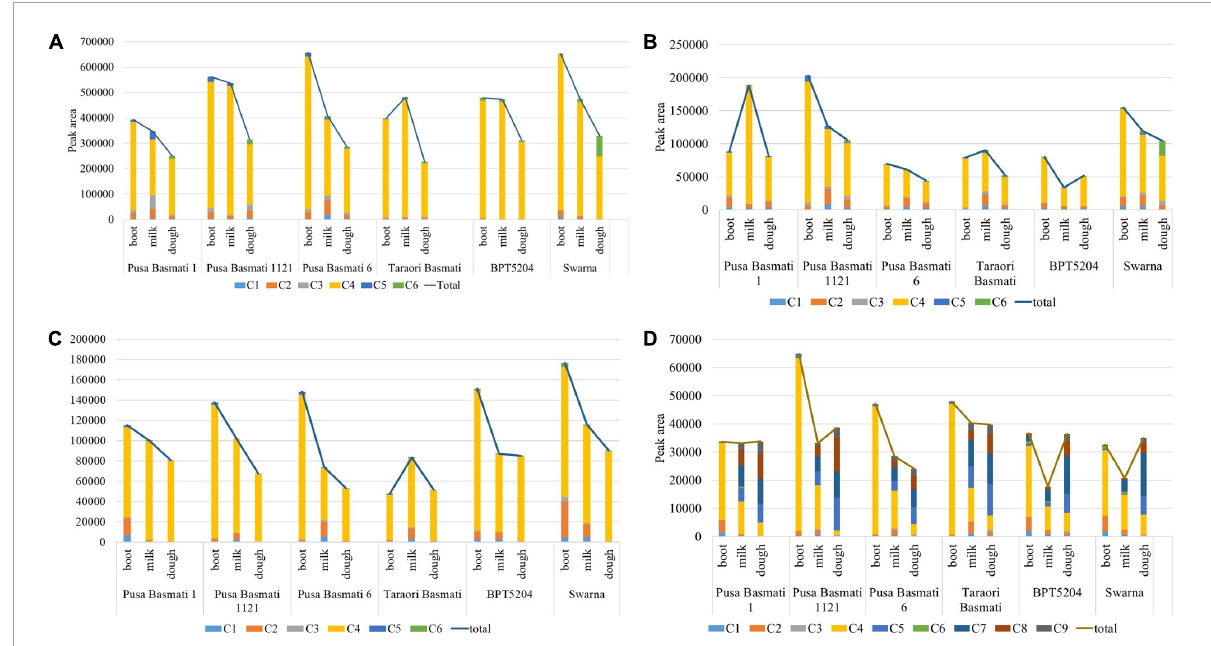
FIGURE4 Cultivar-specific variation for total γ -oryzanol and its components in (A) leaf blade, (B) leaf sheath, (C) peduncle and (D) spikelet; C1: 24-methylenecycloartanyl- p -coumarate; C2: (cid:49) 7-stigmastenyl ferulate; C3: stigmasteryl ferulate; C4: cycloartenyl caffeate; C5: cycloartenyl ferulate; C6: campesteryl caffeate; C7: 24- methylenecycloartanyl ferulate; C8: campesteryl ferulate; C9: β -sitosteryl